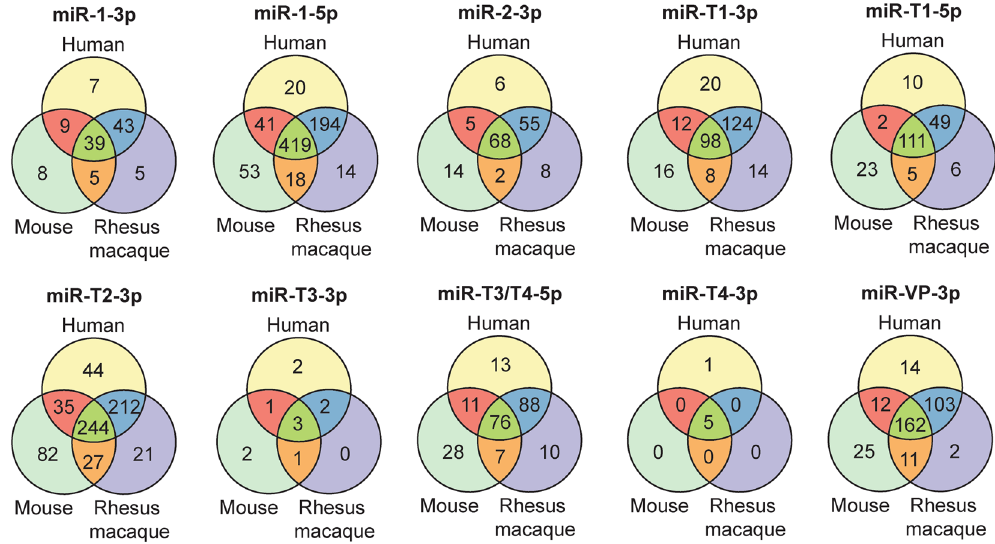
Figure 5. EBOV-encoded miRNAs target a conserved set of genes in human, rhesus macaque, and mouse. A majority of the EBOV-encoded miRNA target genes are conserved in humans, rhesus macaques, and mice. Venn diagrams denote the overlaps in the genes predicted using viral miRNA seed sequences input into TargetScan Custom v5.2 for each species.